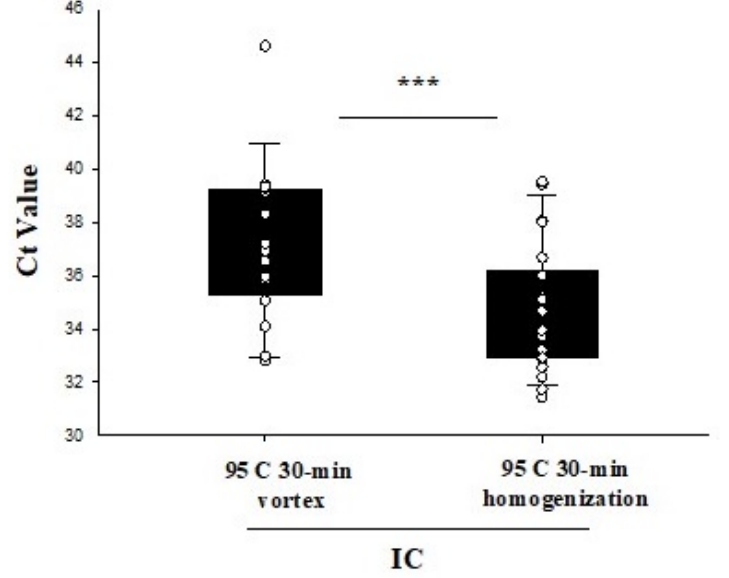
Figure 3. IC Ct values of twenty-two saliva samples subjected to 95 ◦ C for 30 min, and either vortexed for 30 s or homogenized followed by direct RT-PCR. *** p < 0.001.